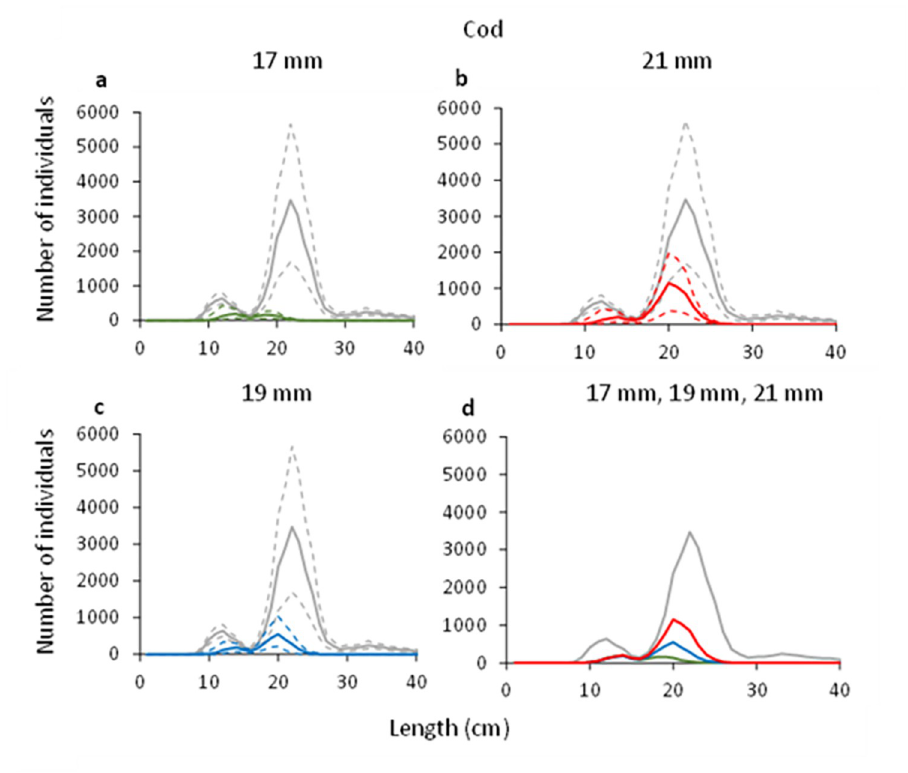
Fig 8. Number of retained cod and the entry population (grey line) when using grid with 17 mm (green), 19 mm (blue) and 21 mm (red) bar spacing. Stippled lines represent the 95% CI’s.